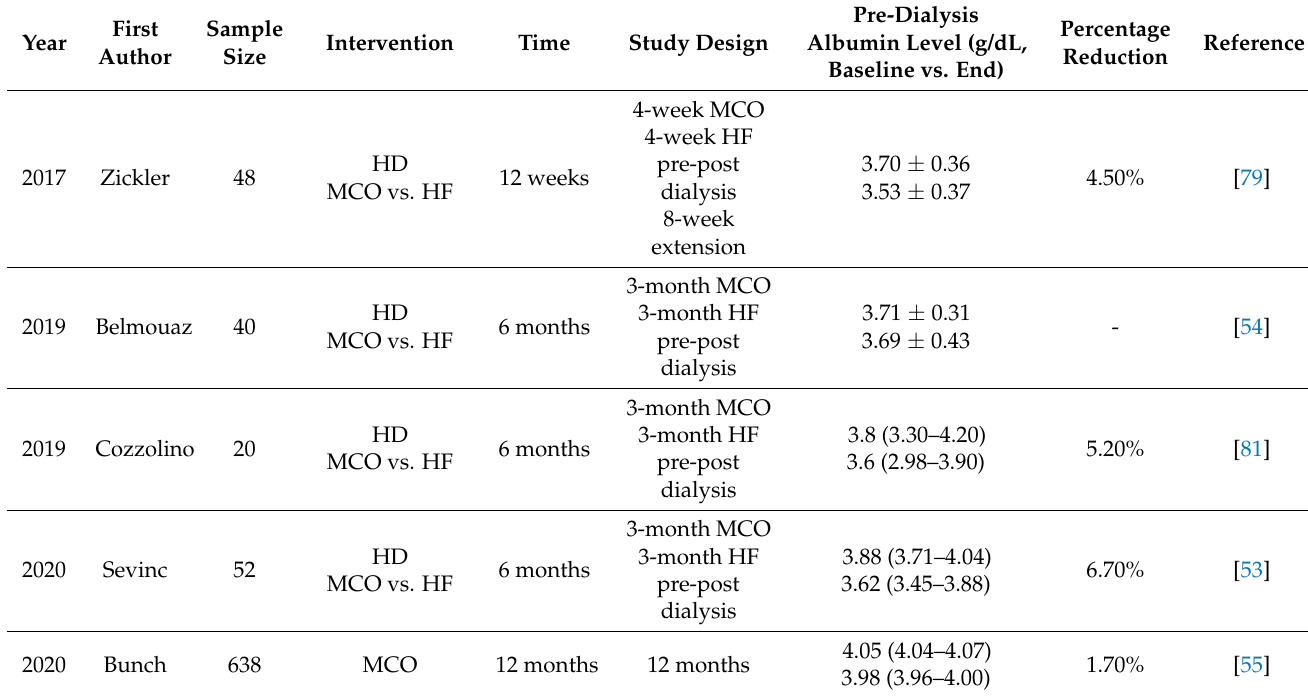
Table 4. Negative effect of MCO membranes on albumin removal. Researchers observed significantly decreased plasma albumin in these